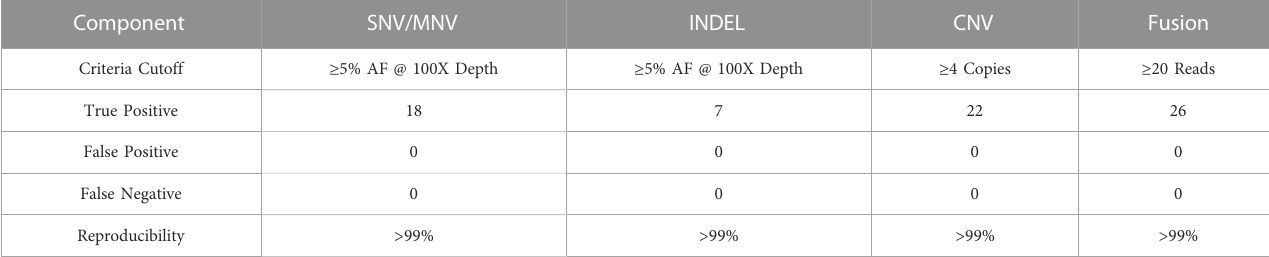
TABLE 15 Repeatability and Reproducibility. Inter-assay Reproducibility.